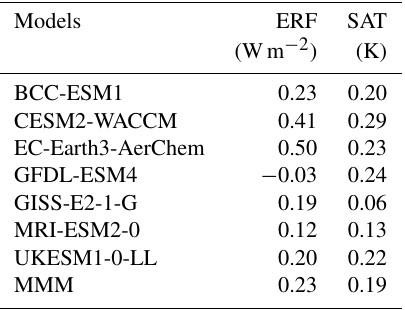
Table 3. Global effective radiative forcing (ERF) and surface air temperature (SAT) responses to non-methane SLCF